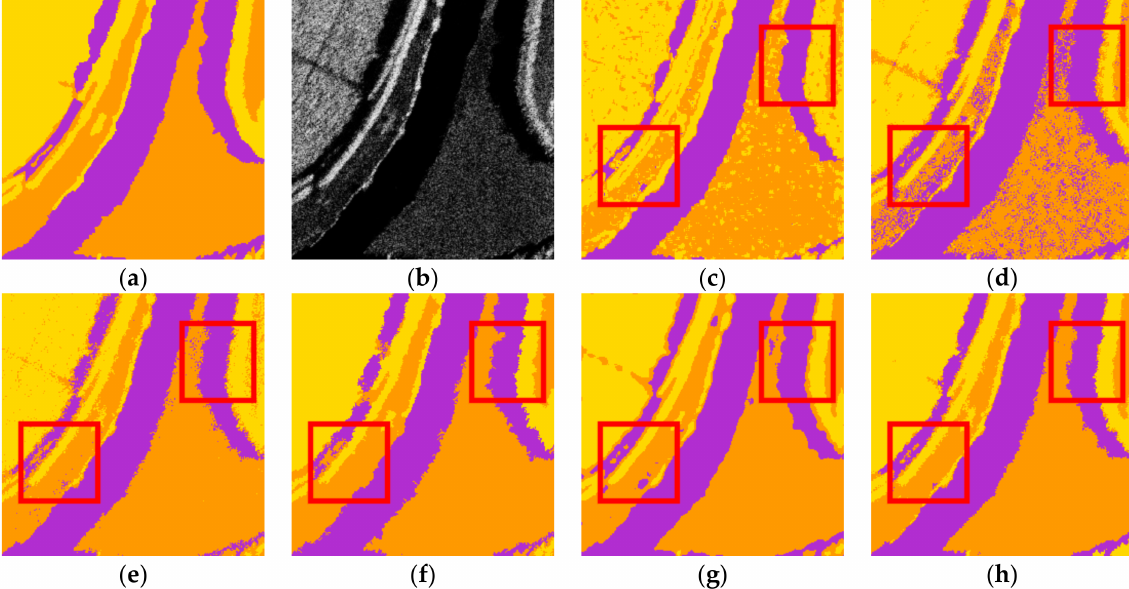
Figure 6. Results of a real SAR image: ( a ) ground truth; ( b ) real SAR image; ( c ) SVM; ( d ) CKS-FCM; ( e ) CKFF; ( f ) SVM-CK; ( g ) MWSG; ( h )